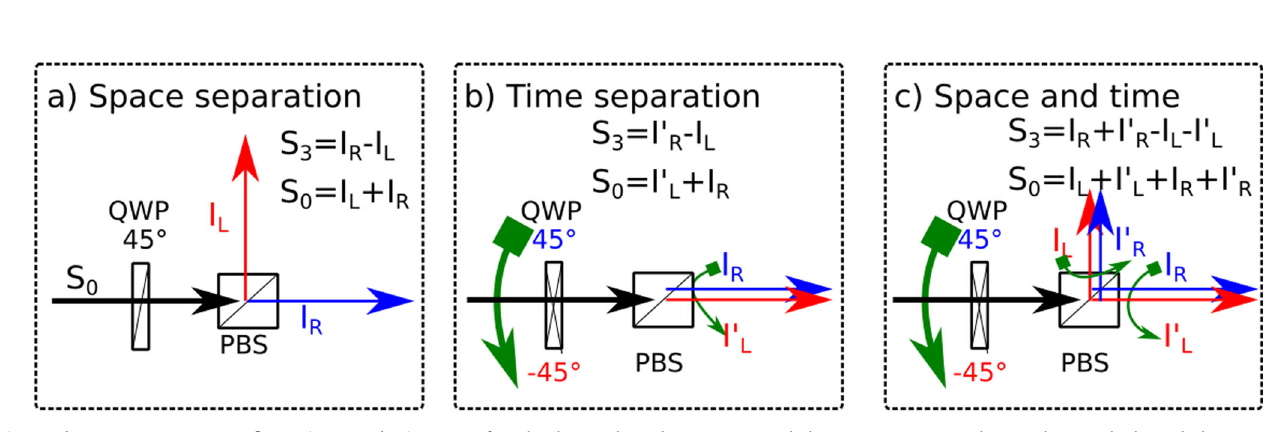
Fig. 1 | Schematic of the CCD-based CPLspectrophotometer. The fl uorescence light is collected via lens L 1 . After the quarter waveplate (QWP, main axis 45 ∘ ) and the polarizing beam spliter (PBS, main axis 0 ∘ ) the LHCP and RHCP are transmittedand re fl ected respectively(ashorizontallyand verticallypolarized light). The two beams are launched into two fi bers with a lens L 2 , for each arm. These two fi bers merge as a bundle. The bundle output is imaged via lens L 3 as